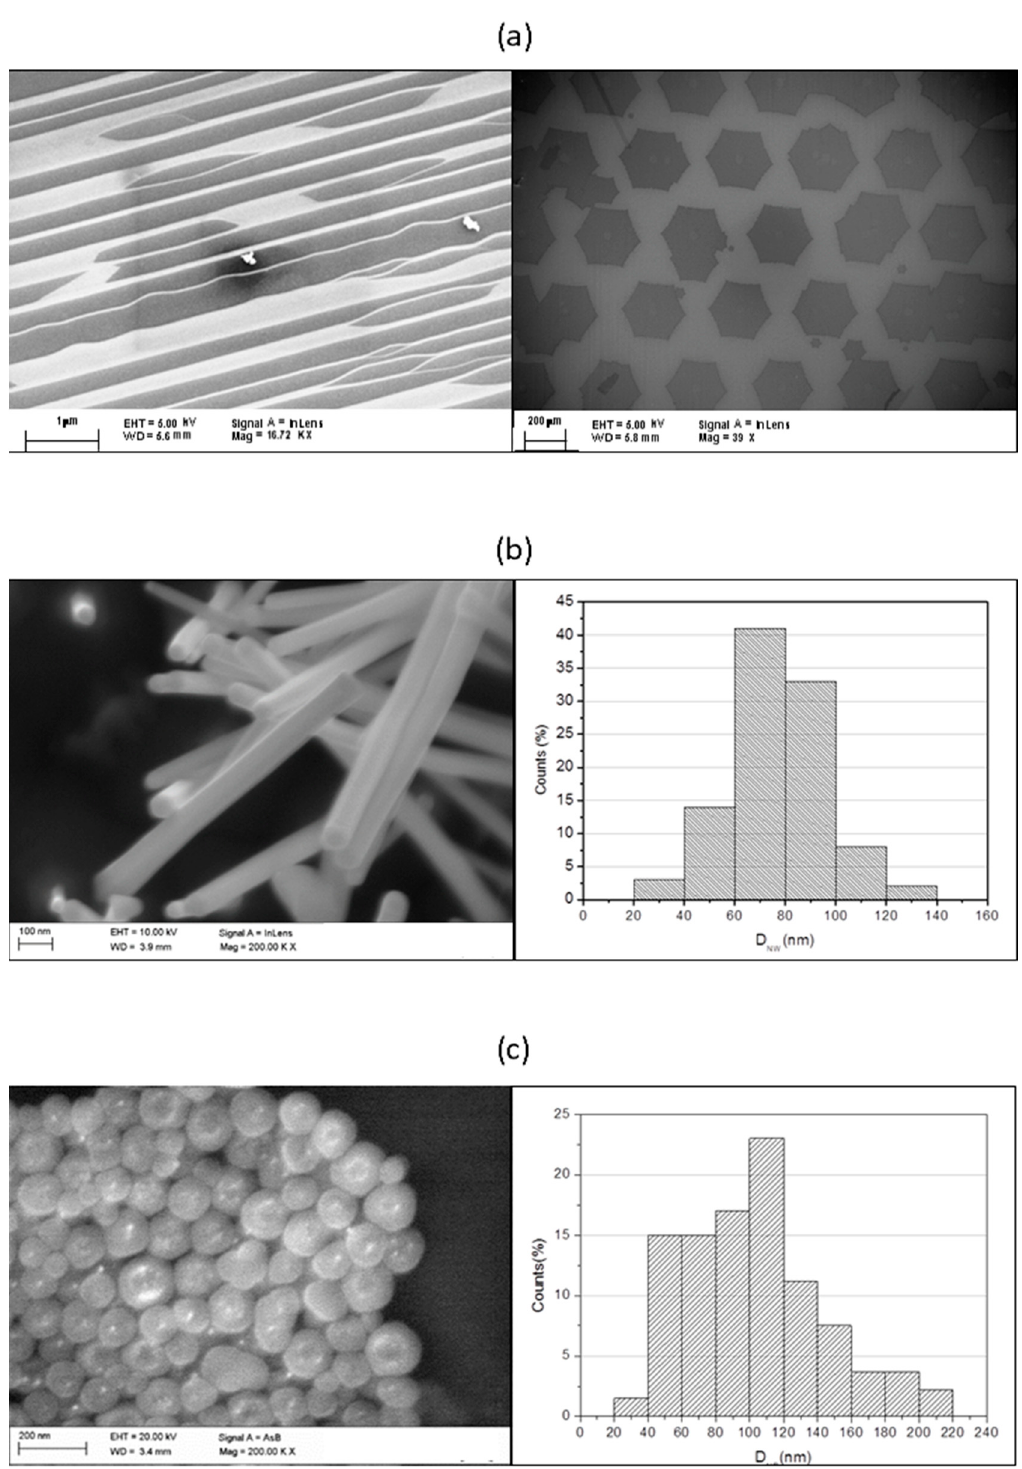
Figure 2. SEM images of: ( a ) graphene (G) deposited on SiC ( left panel) and Cu ( right panel) substrates, magnification 16.72 Kx and 39 x; ( b ) InAs nanowires (NW) and histogram of section diameter size distribution (D NW ), magnification 200 Kx; ( c ) SiO 2 core shell with Au nanostructures (NP) and histogram of diameter size distribution (D NP ), magnification 200 Kx.